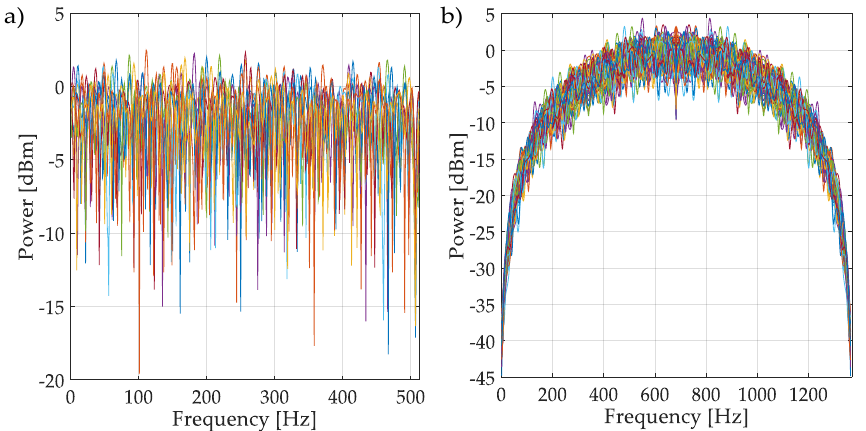
Figure 10. ( a ) Realizations of an OFDM spectrum. ( b ) Realizations of NRZ-CDMA spectrum. Table 1. Mean and variance of the HFD applied to multiple simulated OFDM and NRZ-CDMA symbols without noise.